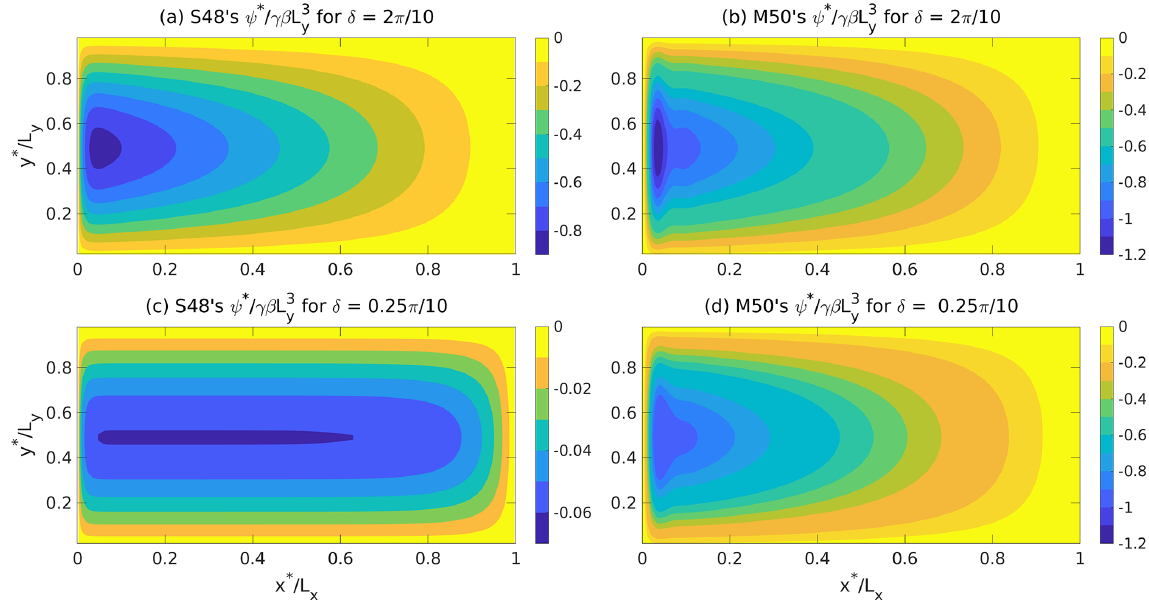
Figure 2. Numerically obtained, non-dimensional stream functions for (cid:15) = 0 . 01 and L x = 10000km. (a) S48’s model with δ = 2 π/ 10, (b) M50’s model with δ = 2 π/ 10. Panels (c) and (d) are the same as (a) and (b) but for δ = 0 . 25 π/ 10; i.e., the meridional extent of the basin is one-eighth of that in (a) and (b) . Note the different color bars in panels (a) and (c)